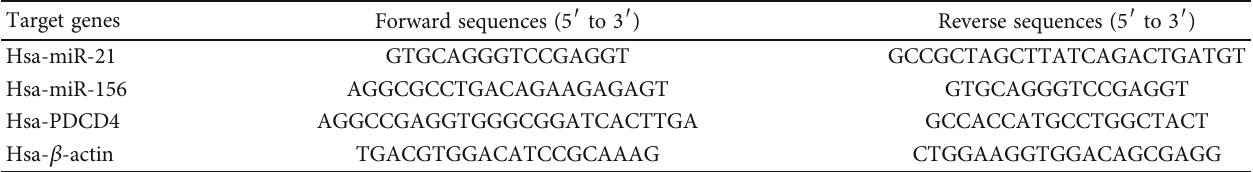
Table 1: Primer sequences of target proteins and their relationship with mir-21 and PDCD4. Target genes